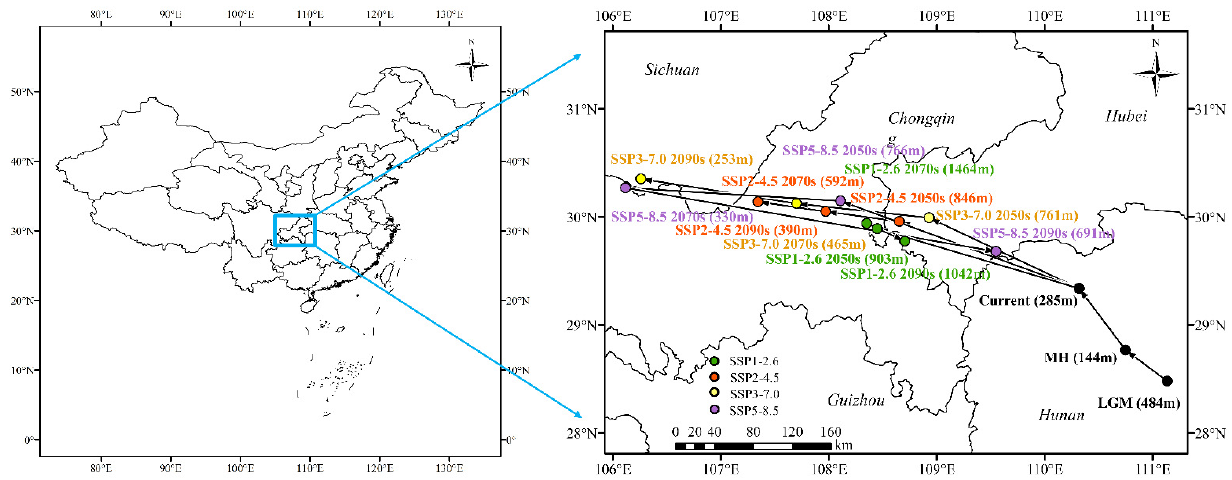
Figure 7. Core distribution shifts under 12 climate scenarios/years. Arrows indicate the magnitude and direction of predicted changes over